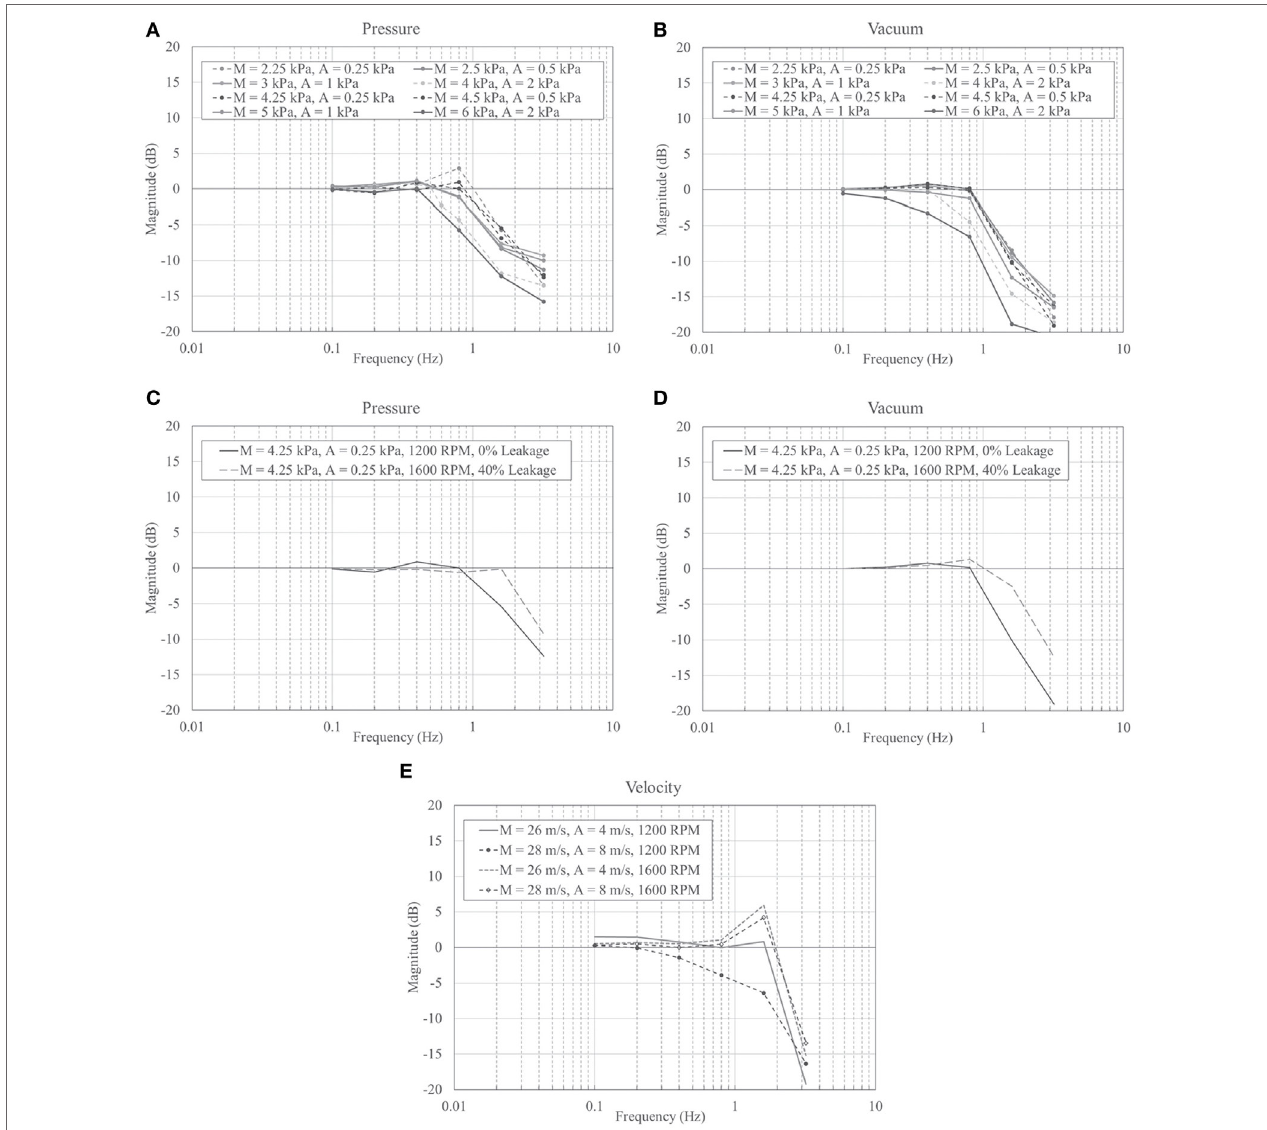
FigUre 2 | Bode plots for no-leakage (impact wall sealing the pressure box), 1,200 rPM fan speed positive pressure (a) and negative pressure (B) sine wave function for various mean (M) and amplitude (a) settings, and no-leakage/artificial leakage comparison for positive pressure (c) and negative pressure (D) sine wave function with mean of 4.25 kPa (89 psf) and amplitude of 0.25 kPa (5 psf); simulator run at 1,200 rPM with 0% artificial leakage and 1,600 rPM with 40% artificial leakage induced by partial opening of atmospheric outlet (c) or inlet (D) butterfly valves; and for velocity (e) sine wave function for various mean (M) and amplitude (a) settings